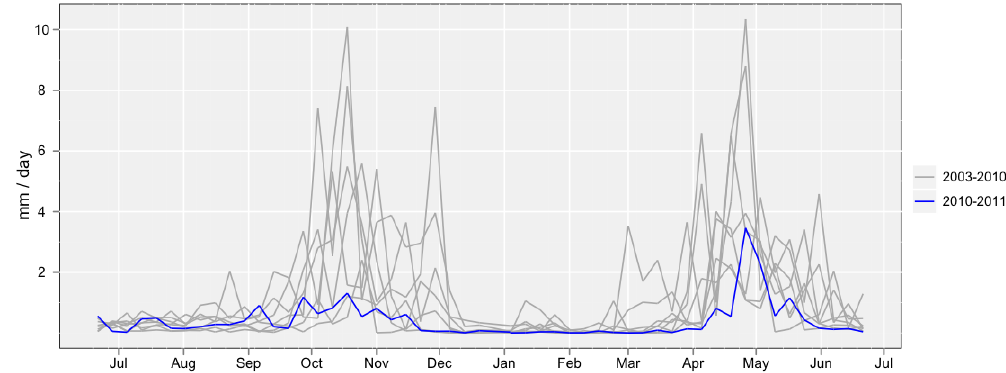
Fig. 2. TMPA 3B42 precipitation estimates from 2003–2011: blue=2010–2011; gray=all other